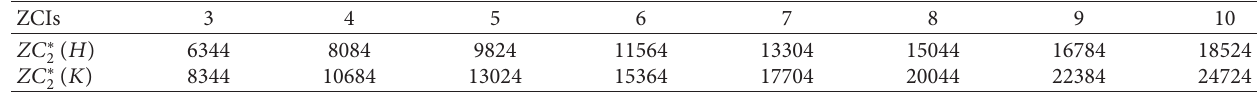
for H and K networks on dimensions 3 ≤ n ≤ 10. 2